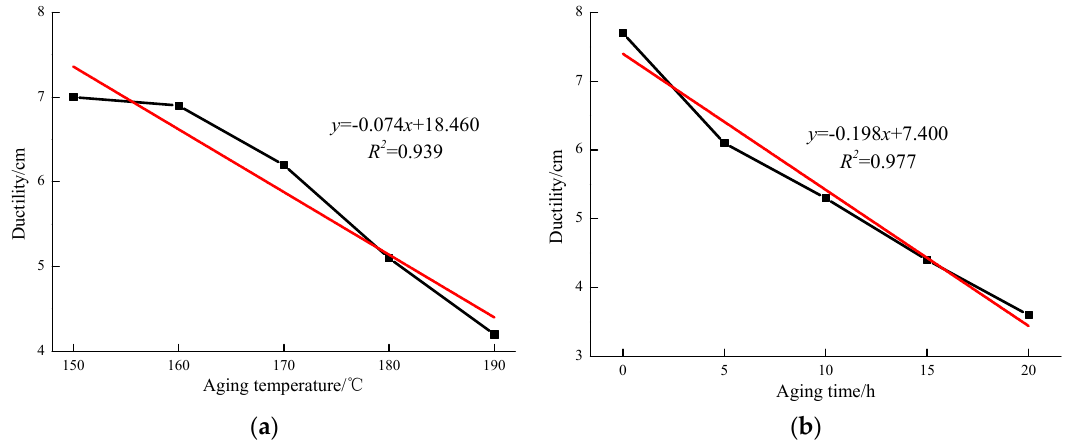
Figure 2. Penetration values of MACRMA at different aging conditions: ( a ) aging temperature and